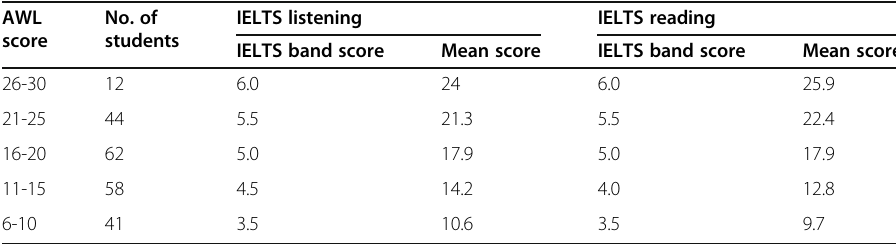
Table 8 Relationship between academic vocabulary knowledge and academic listening and reading comprehension AWL